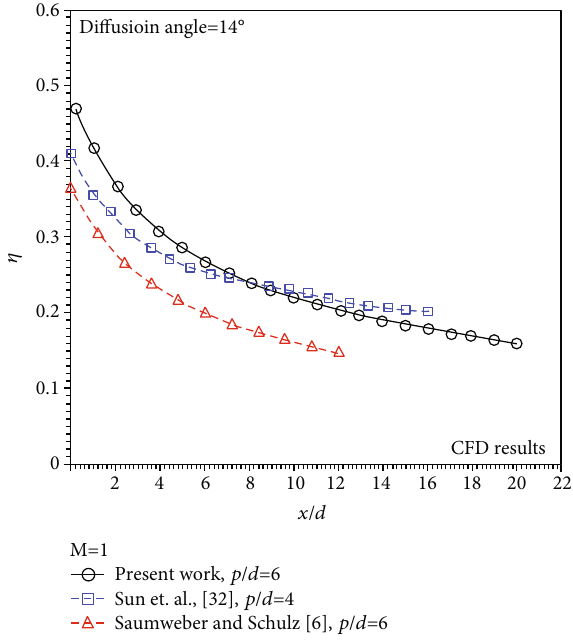
Figure 28: A comparison between the present work and CFD studies in open